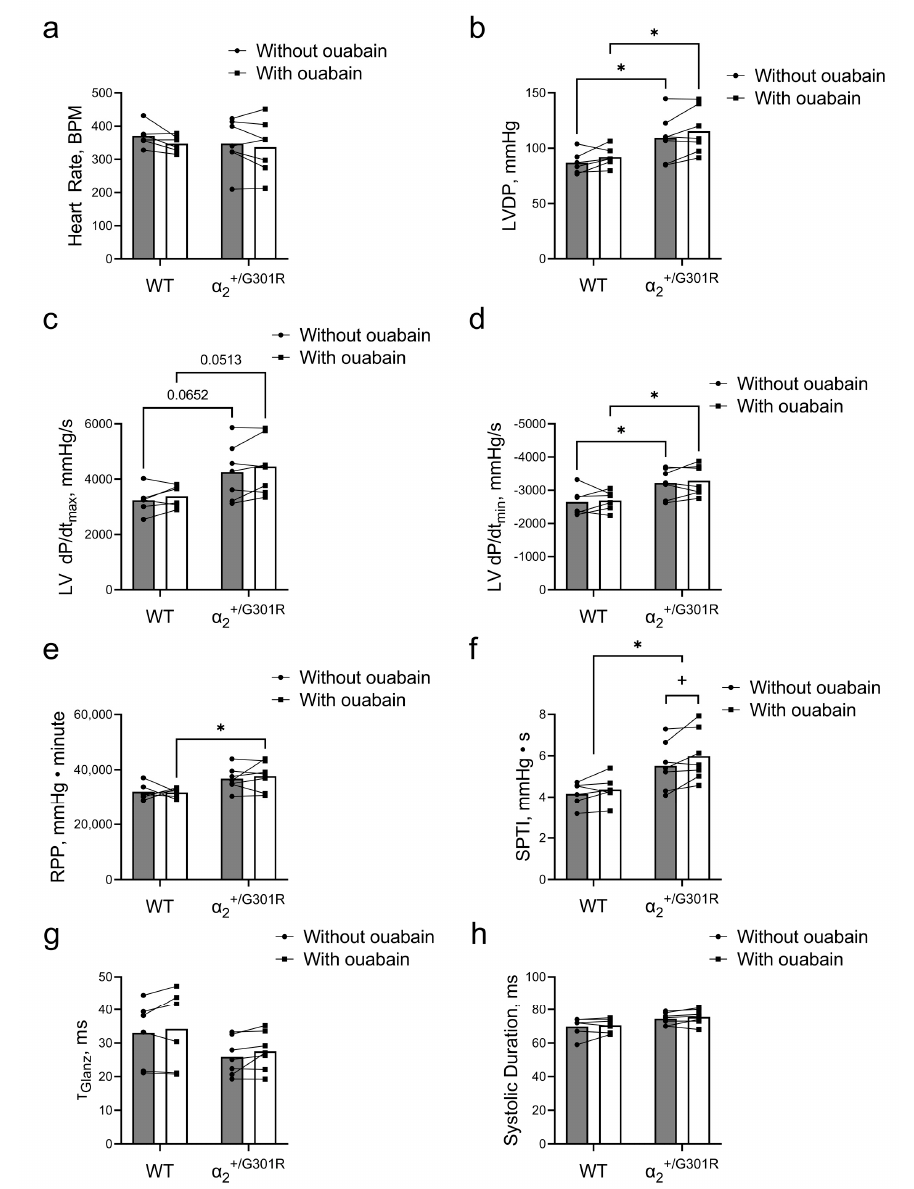
Figure 5. In the presence of ouabain during sinus rhythm, systolic work increased only for α 2+/G301R hearts and not for WT hearts . ( a ) Heart rate was unaffected in the presence of ouabain in both genotypes. ( b ) The left-ventricular-developed pressure (LVDP) of α 2+/G301R hearts remained greater than that of WT hearts. ( c ) The differences in left ventricular dP/dt max (LV dP/dt max ) between the genotypes did not achieve statistical significance in the absence of ( p = 0.0652) or in the presence of ouabain ( p = 0.0513). ( d ) The difference in left ventricular dP/dt min (LV dP/dt min ) between WT and α 2+/G301R hearts remained in the presence of ouabain. ( e ) The rate–pressure product (RPP) between the two genotypes was different only in the presence of ouabain, and ( f ) the systolic pressure–time index (SPTI) remained larger for α 2+/G301R hearts than for WT hearts and it was only increased for α 2+/G301R hearts in the presence of ouabain. ( g ) τ Glanz and ( h ) the systolic duration did not change in the presence of ouabain. Data were compared with a two-way repeated-measures ANOVA followed by Sidak’s multiple comparison test. * p < 0.05; WT vs. α 2 +/G301R variables and + p < 0.05; comparison of intragroup variables. n =